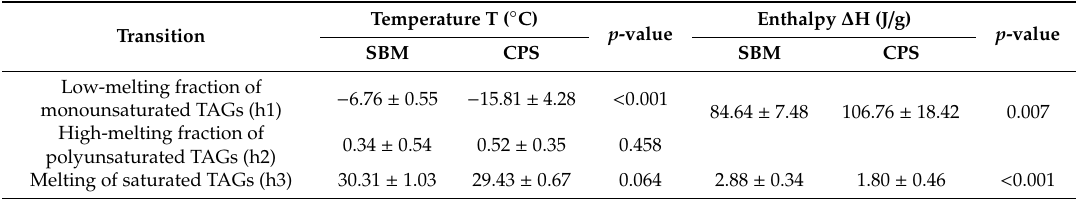
Figure 2. DSC heating thermograms of subcutaneous fat samples from broiler chickens fed soybean meal (SBM) and chickpea seeds (CPS). Exothermal processes are directed up. Table 3. DSC melting parameters of subcutaneous fat of broiler chickens fed soybean meal and chickpea seeds.